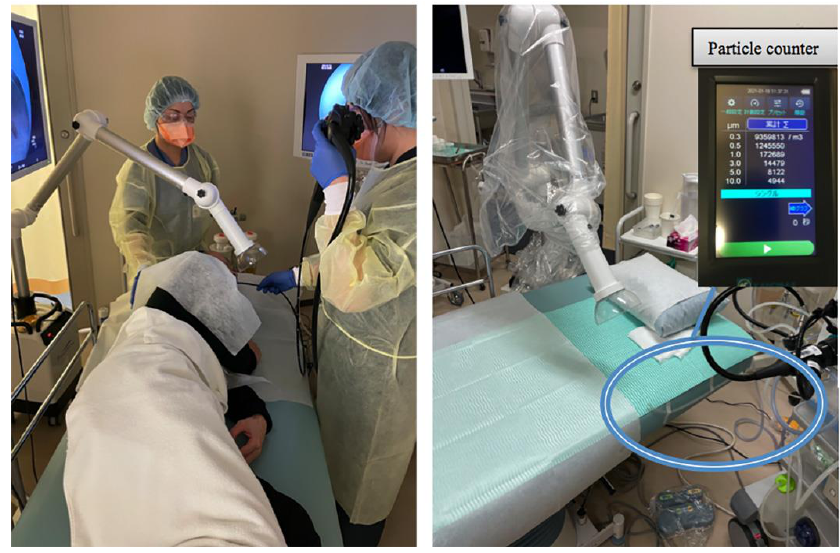
Figure 1. Aerosol particles were measured with a particle counter (model 3889; Kanomax Japan Inc., Osaka, Japan) in the patient’s mouth. Osaka, Japan) in the patient’s